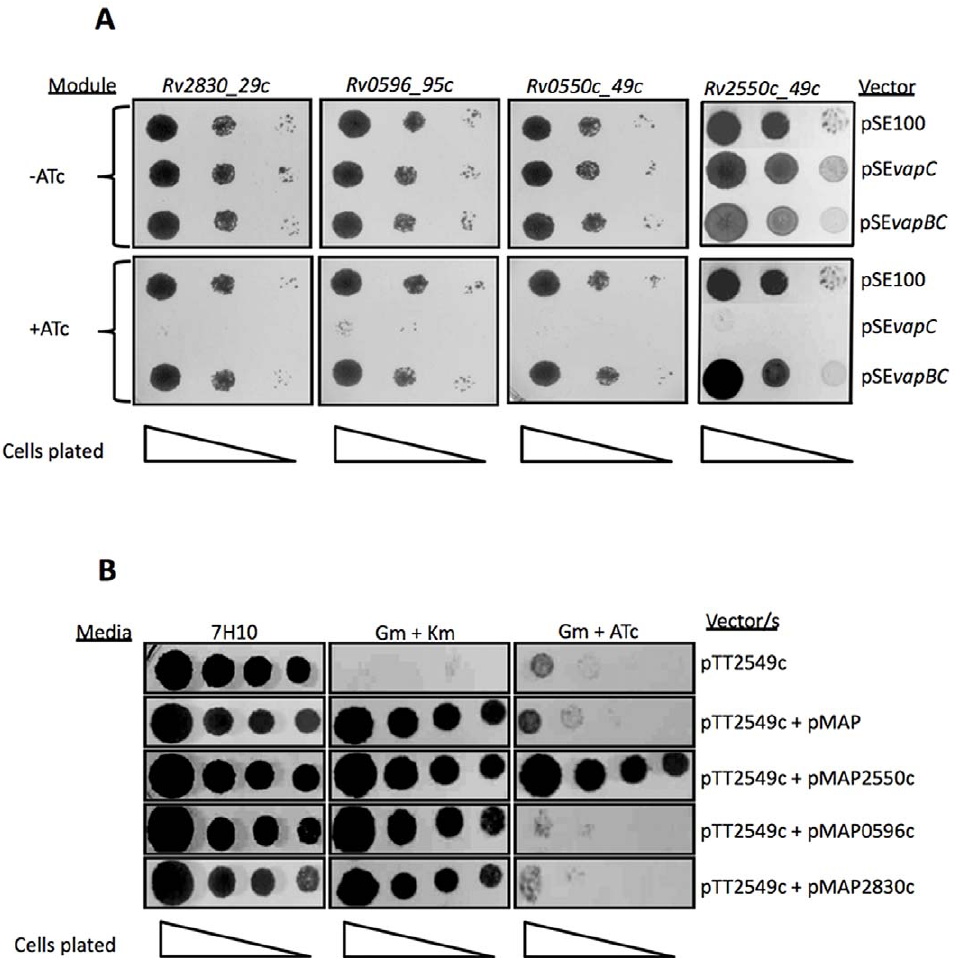
Figure 5. Neutralization of Mtb VapC toxicity in M.smegmatis by cognate antitoxin expression. A: Cognate toxin-antitoxin modules were co-expressed as an operon under control of the Tet-regulated promoter. Serial dilutions were plated on 7H10 agar alone (-ATc) or with ATc at 25 ng/ ml ( + ATc). B: Toxin and antitoxin genes were expressed separately on Tweety ( vapC ) or L5-based integration vectors ( vapB ) under control of Tet- or acetamide-regulated promoters, respectively. Serial dilutions were plated on 7H10 agar alone or supplemented with Gm and Km, or Gm and ATc (50 ng/ml).